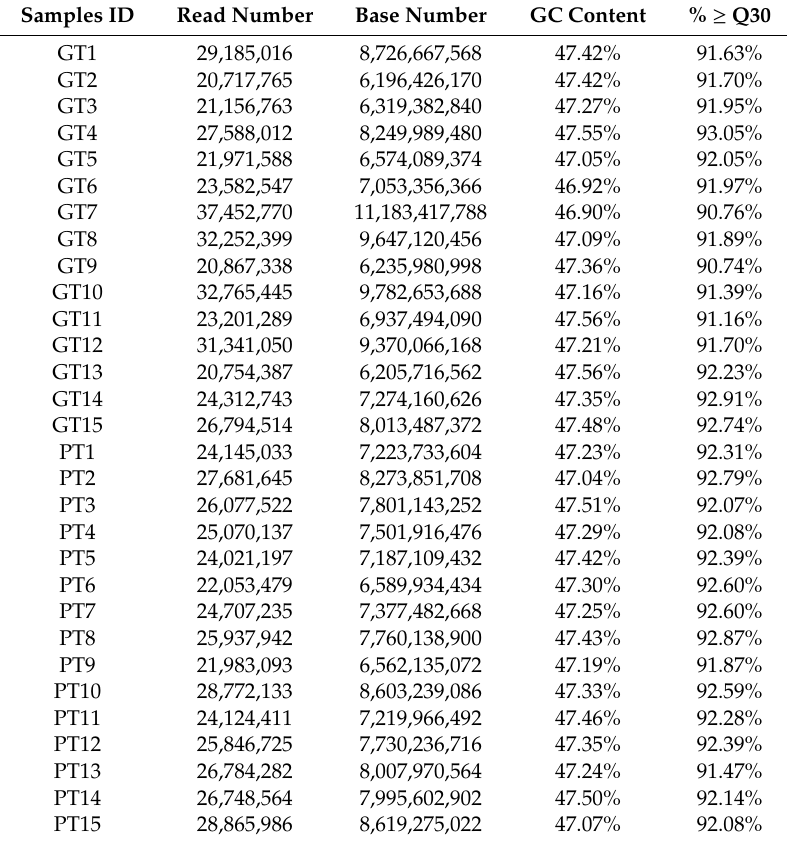
Table 1. Overview of the transcriptome sequencing dataset and quality check.